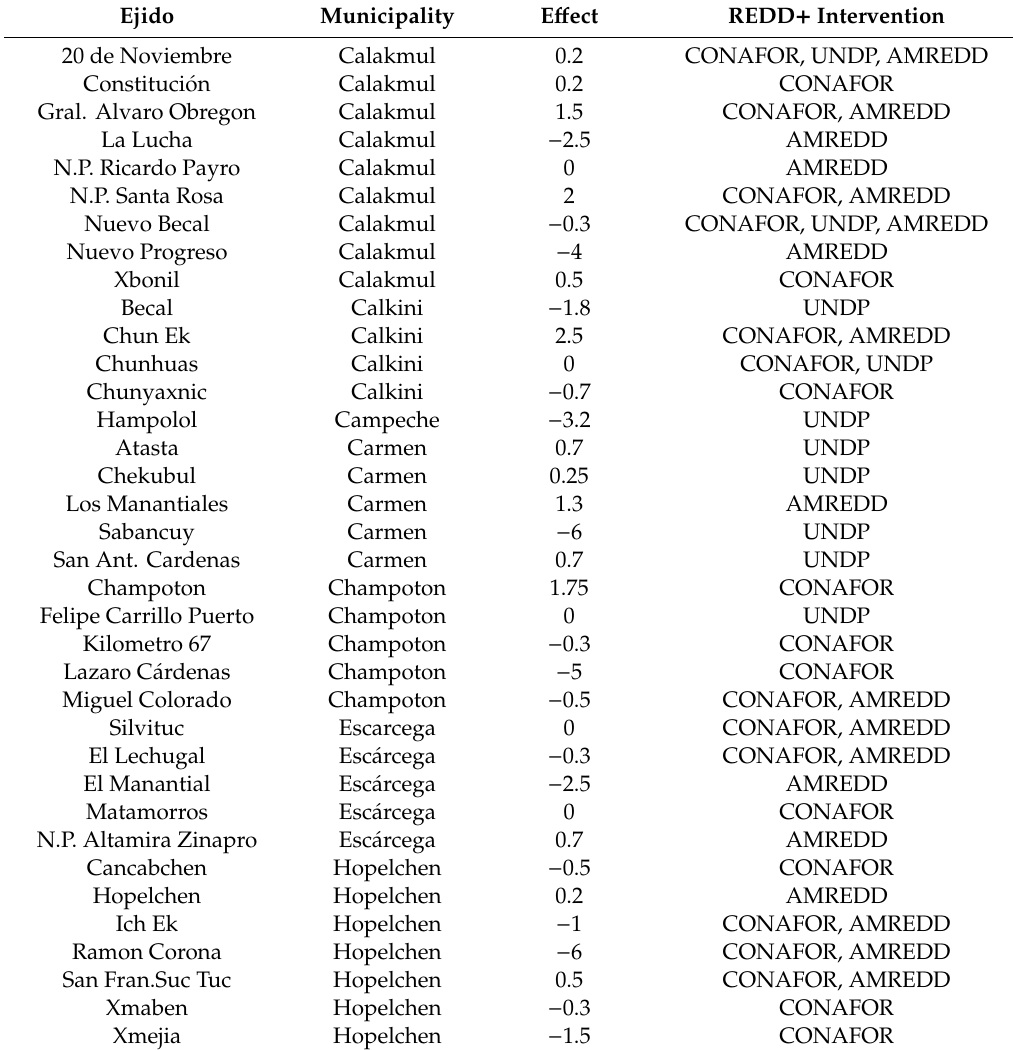
Table A1. Synthetic Control Method (SCM) results of treated unit e ff ects for each REDD + community (ejido) in the state of Campeche (CONAFOR = National Forestry Commission, UNDP = United Nations Development Program, AMREDD = Mexico REDD +